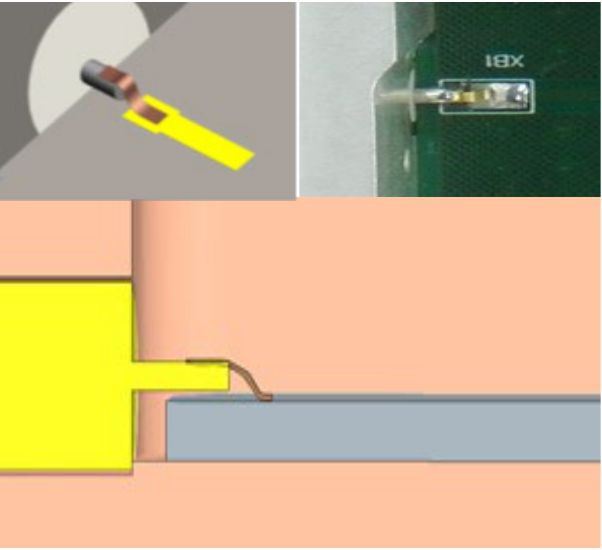
Figure 4. Gold-ribbon lap bonding structure.